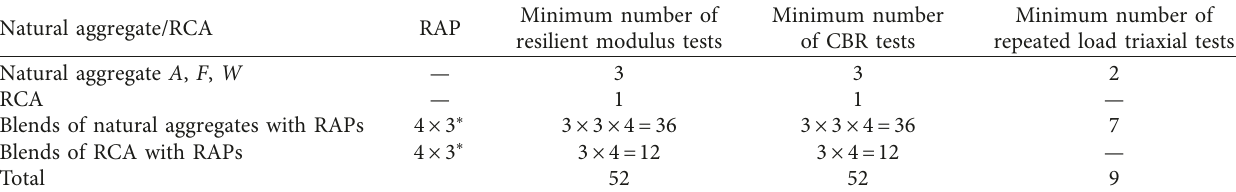
Table 3: Matrix of the testing program.